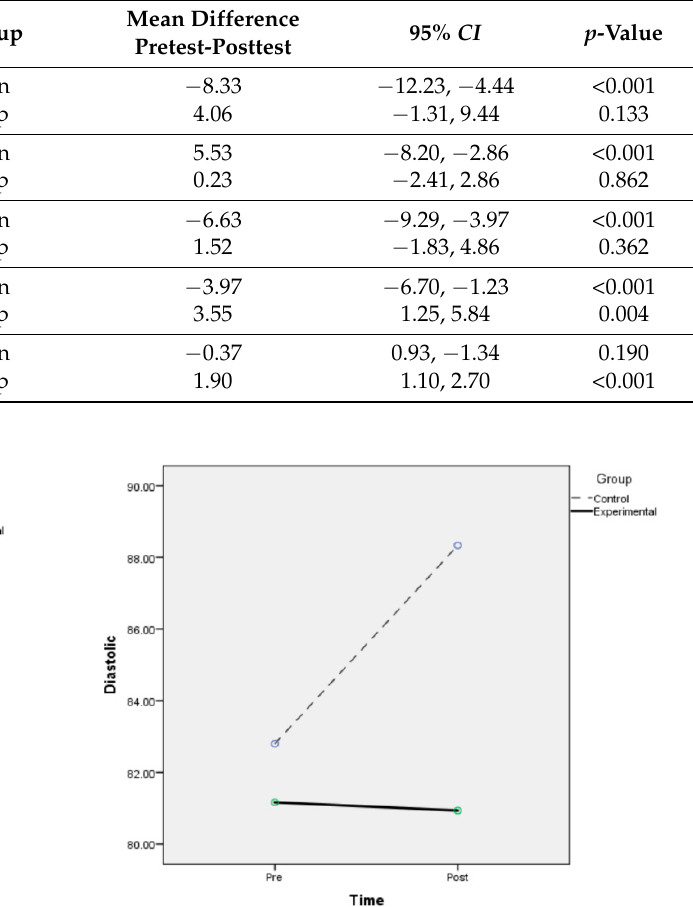
Table 5. Mean differences between pretest and posttest within control and experimental groups.